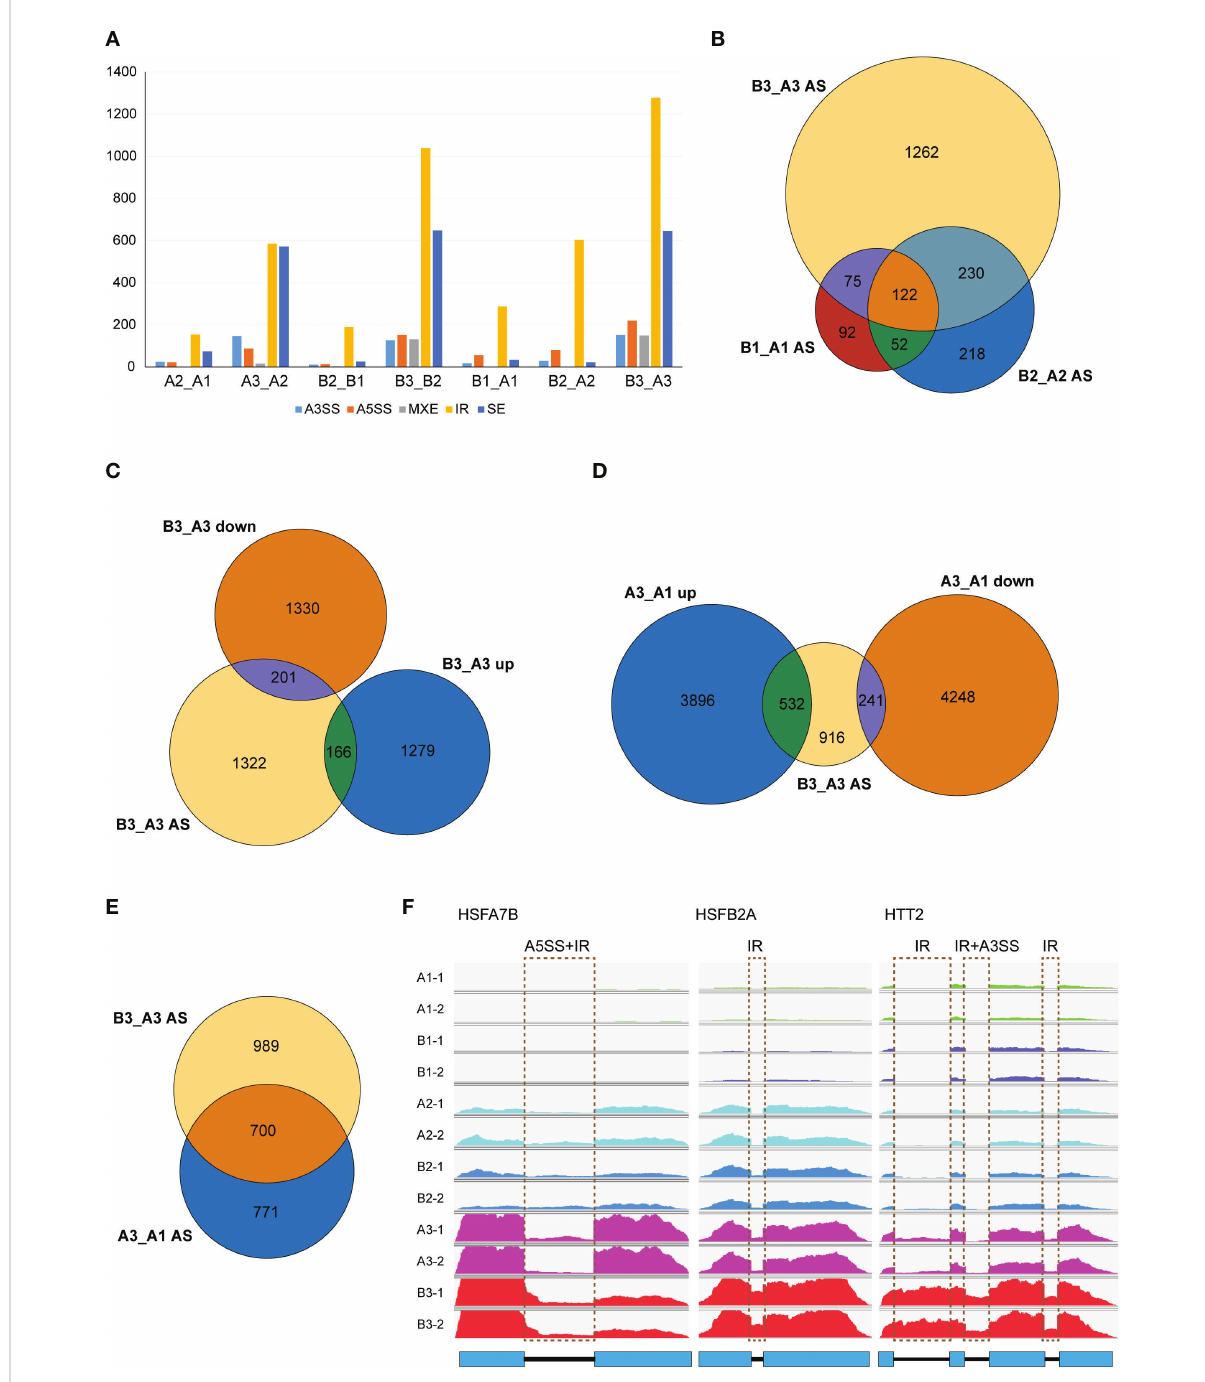
FIGURE 7 NTR1 mutation ampli fi es the alternative splice of HSR genes induced by heat stress. (A) Differential AS events compared between plants with different times of heat treatment or between different genotypes. A3SS, alternative 3 ′ -splice site; A5SS, alternative 5 ′ -splice site; MXE, mutually exclusive exon; IR, intron retention; SE, skipped exon. (B) Venn diagrams of common genes with different AS events between hl761 mutants and CK at different times of heat treatment. (C) Venn diagrams of common genes with different AS events and DEGs of hl761 vs. CK after 60-min heat treatment. (D) Venn diagrams of common genes between genes with different AS events of hl761 vs. CK after 60-min heat treatment and heat-induced or heat-repressed genes by 60-min heat treatment. (E) Venn diagram of common genes between genes with different AS events of hl761 vs. CK after 60-min heat treatment and genes with heat-induced AS events. (F) Examples of heat stress response (HSR) genes with altered AS induced by heat stress. CK, background line for hl761 ; AS, alternative splicing; DEGs, differentially expressed